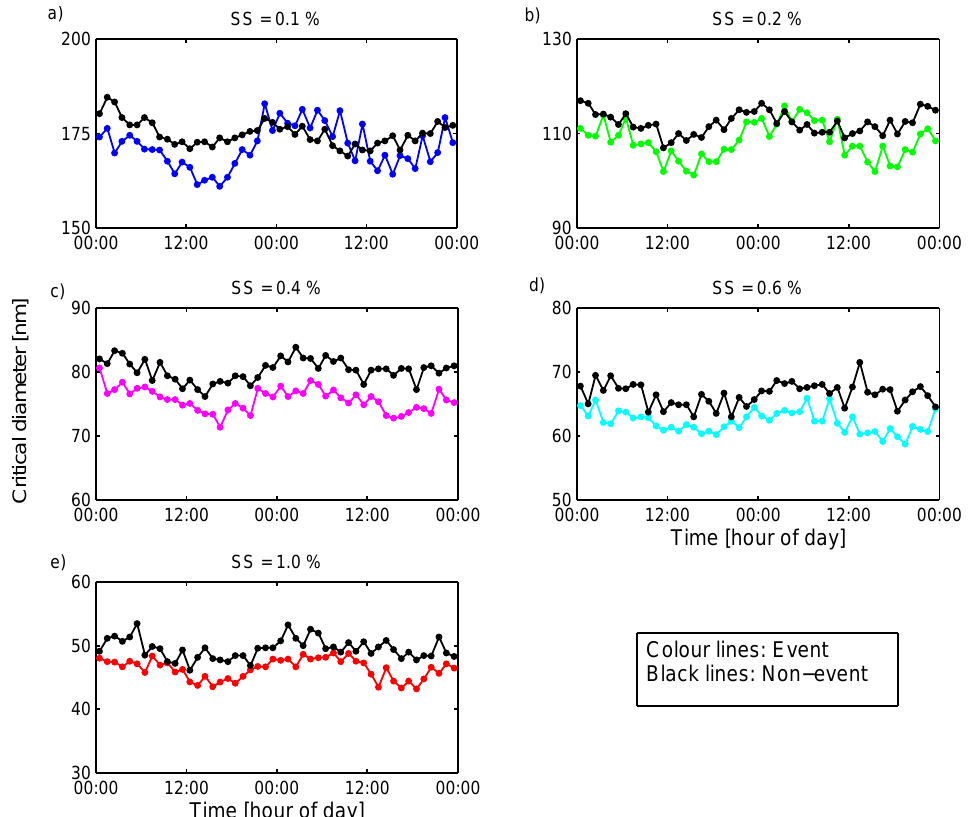
Fig. 9. Same as Fig. 7, but for the critical diameter determined from the CCNC and size distribution